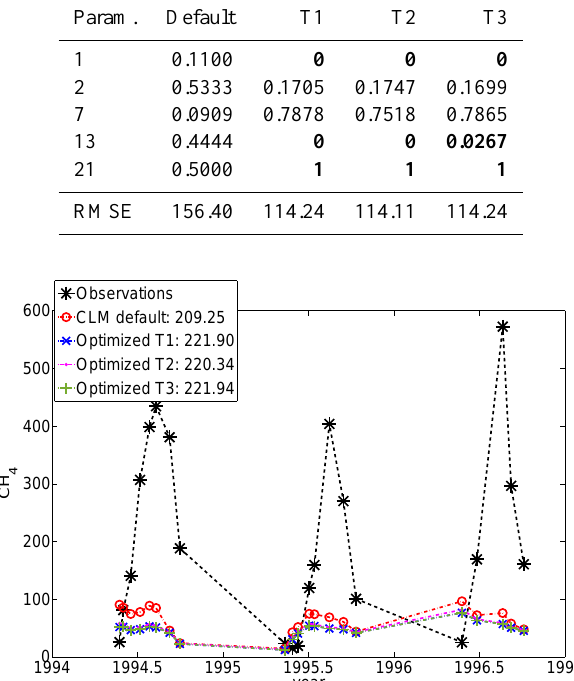
Table 6. Default and optimized parameter values of optimization trials T1, T2, and T3 for the five-dimensional real data case. Bold indicates optimized parameters that are on (or close to) the variable boundary (all variables are scaled to [0,1]). Param.